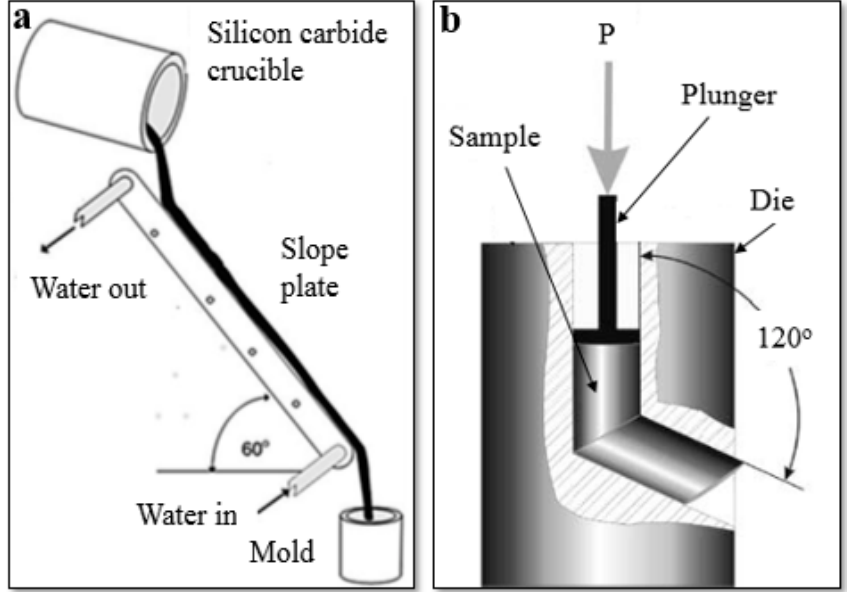
Figure 1. Schematic of ( a ) cooling slope casting and ( b ) ECAP mold.